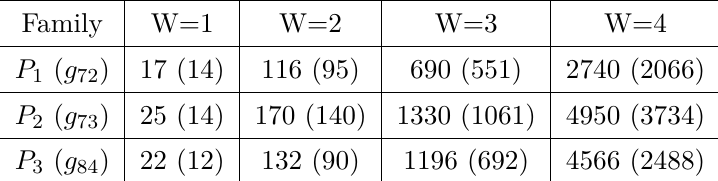
Table 1 . Numbers of GPs entering in the solution, as explained in the